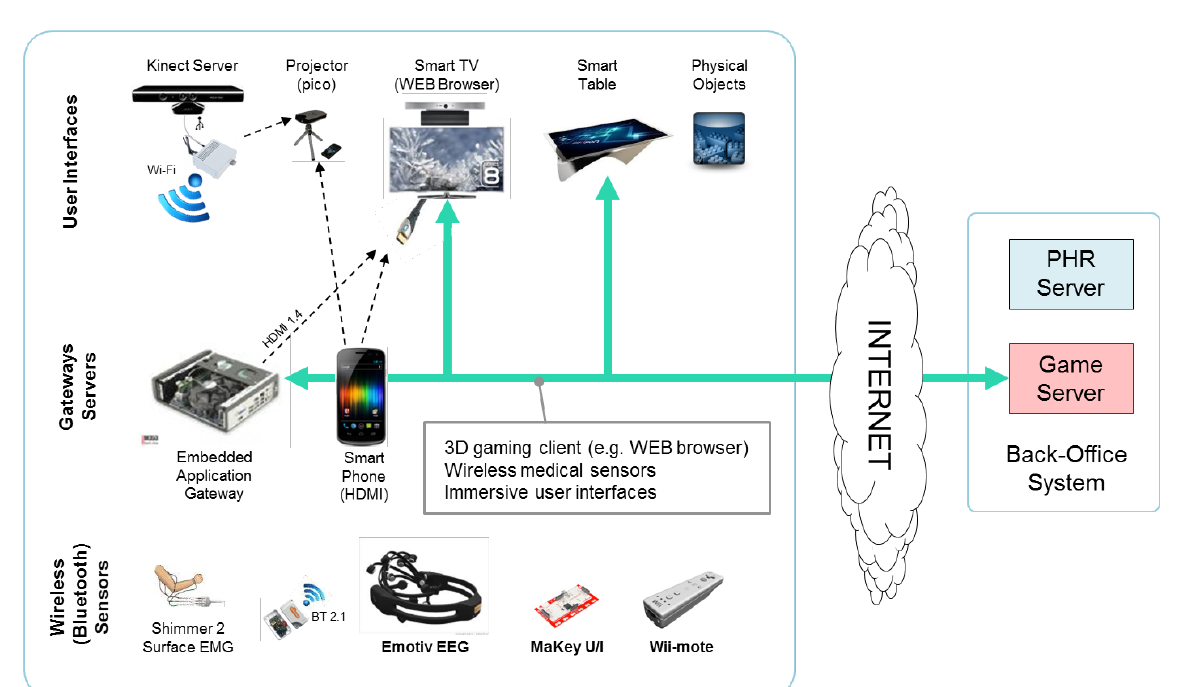
Figure 2 . Physical architecture of a gaming subsystem